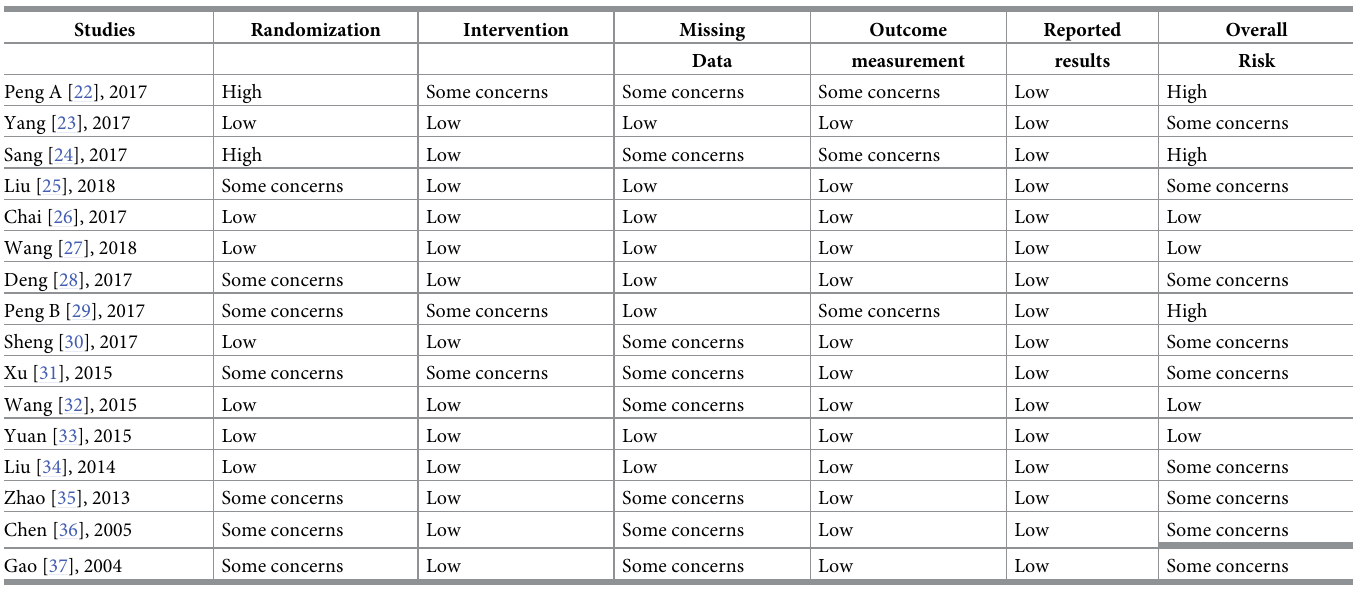
Table 5. Assessment of risk of bias for all included studies using the revised of bias tool (Rob 2.0).